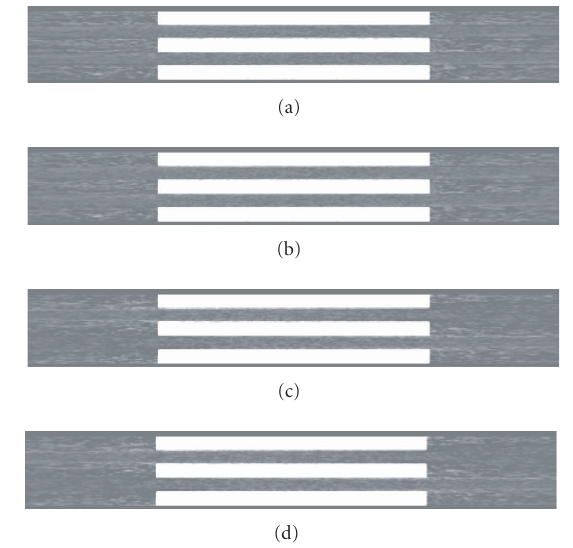
Figure 4: Multiple planar reformatted (coronal) images of the De- frise phantom reconstructed by (a) the original algorithm using full-scan data at helical pitch 33 / 64 : 1; (b) the extended algorithm using overscan data at helical pitch 33 / 64 : 1; (c) the original al- gorithm using full-scan data at helical pitch 63 / 64 : 1; and (d) the extended algorithm using overscan data at helical pitch 63 / 64 : 1 (w/l = 600/0 HU).